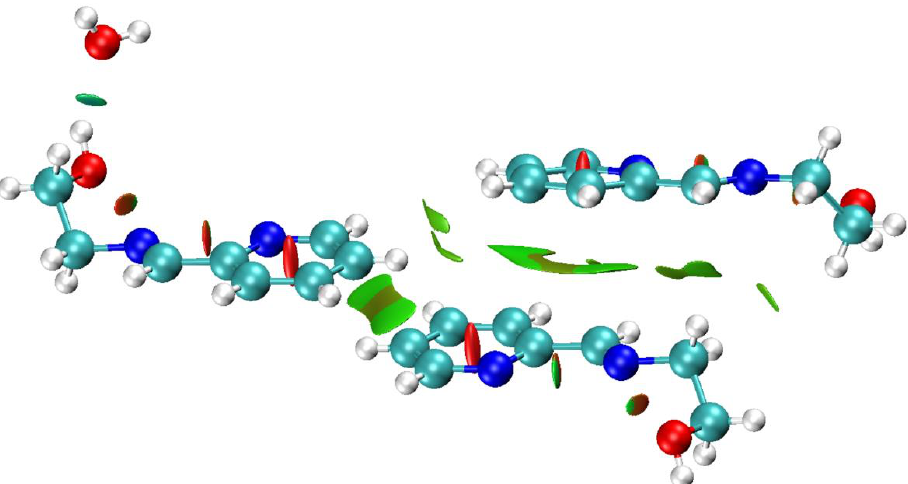
Figure 8. Top left: fragment of the crystal structure of 2 viewed down the c axis showing the HS of the fragment [PbBr 2 (L2)]. Top right: selected fingerprint plots. Bottom: contributions of the specific X i ···X e contacts.